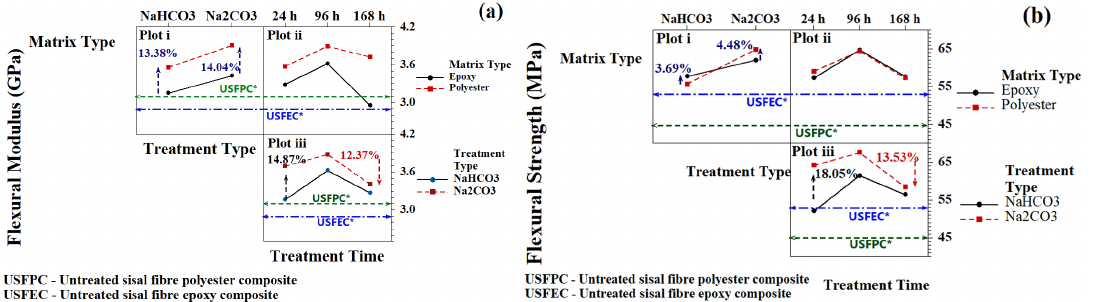
Figure 4. Flexural testing plots for DoE: interaction plots for flexural a) modulus and b)